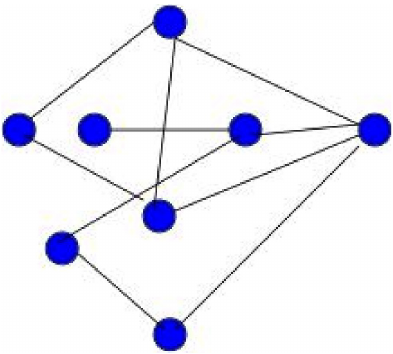
Fig. 7. A cartoon of our “complex” system. Each node satisfies Eq. (15). Lines describes the connectivity matrix L ij